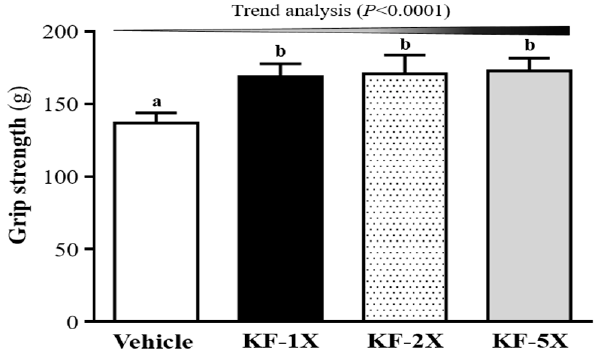
Figure 2. Effects of kefir (KF) supplementation on the forelimb grip strength. Data are presented as mean ± SD, n = 8. Bars with different letters ( a , b ) indicate a significant difference at p < 0.05 determined using one-way ANOVA. Vehicle (glucose water), KF-1X (2.15 g/kg/day KF), KF-2X (4.31 g/kg/day KF), and KF-5X (10.76 g/kg/day KF).